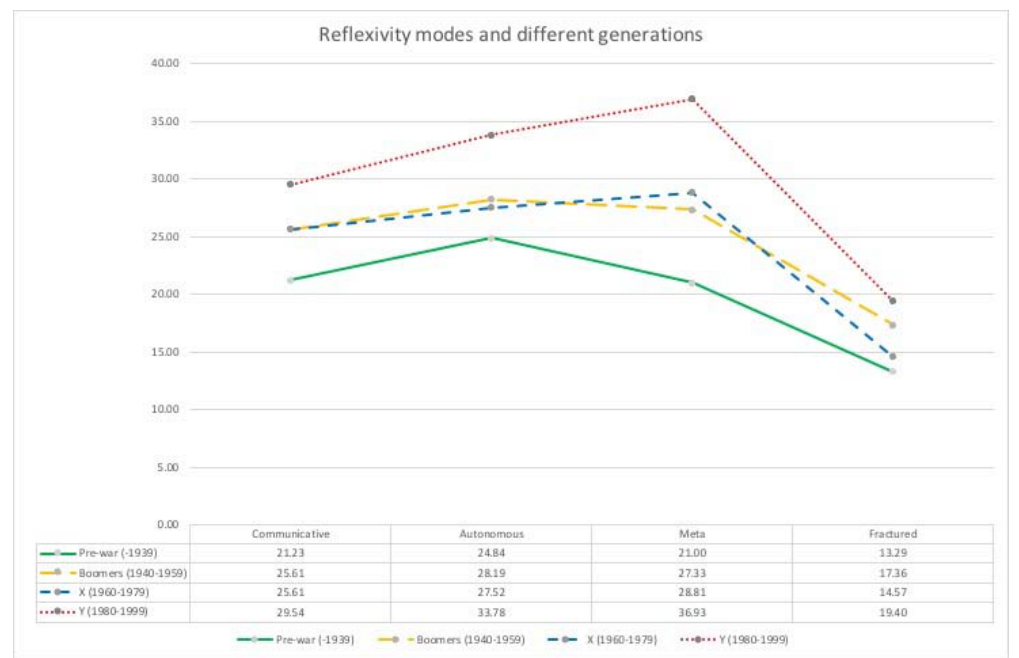
Figure 4. Reflexivity levels for different generations.